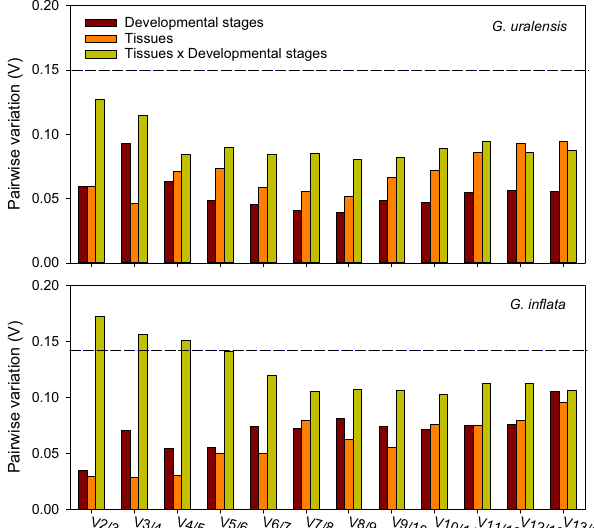
Figure 4. Pairwise variation analysis of the candidate reference genes. Pairwise variation analysis in G. uralensis and G. inflata , respectively, by geNorm procedure. The pairwise variation (V n /V n+1 ) was calculated with the normalization factors NF n and NF n+1 to determine the optimal number of reference genes required for RT-qPCR data normalization under different conditions.